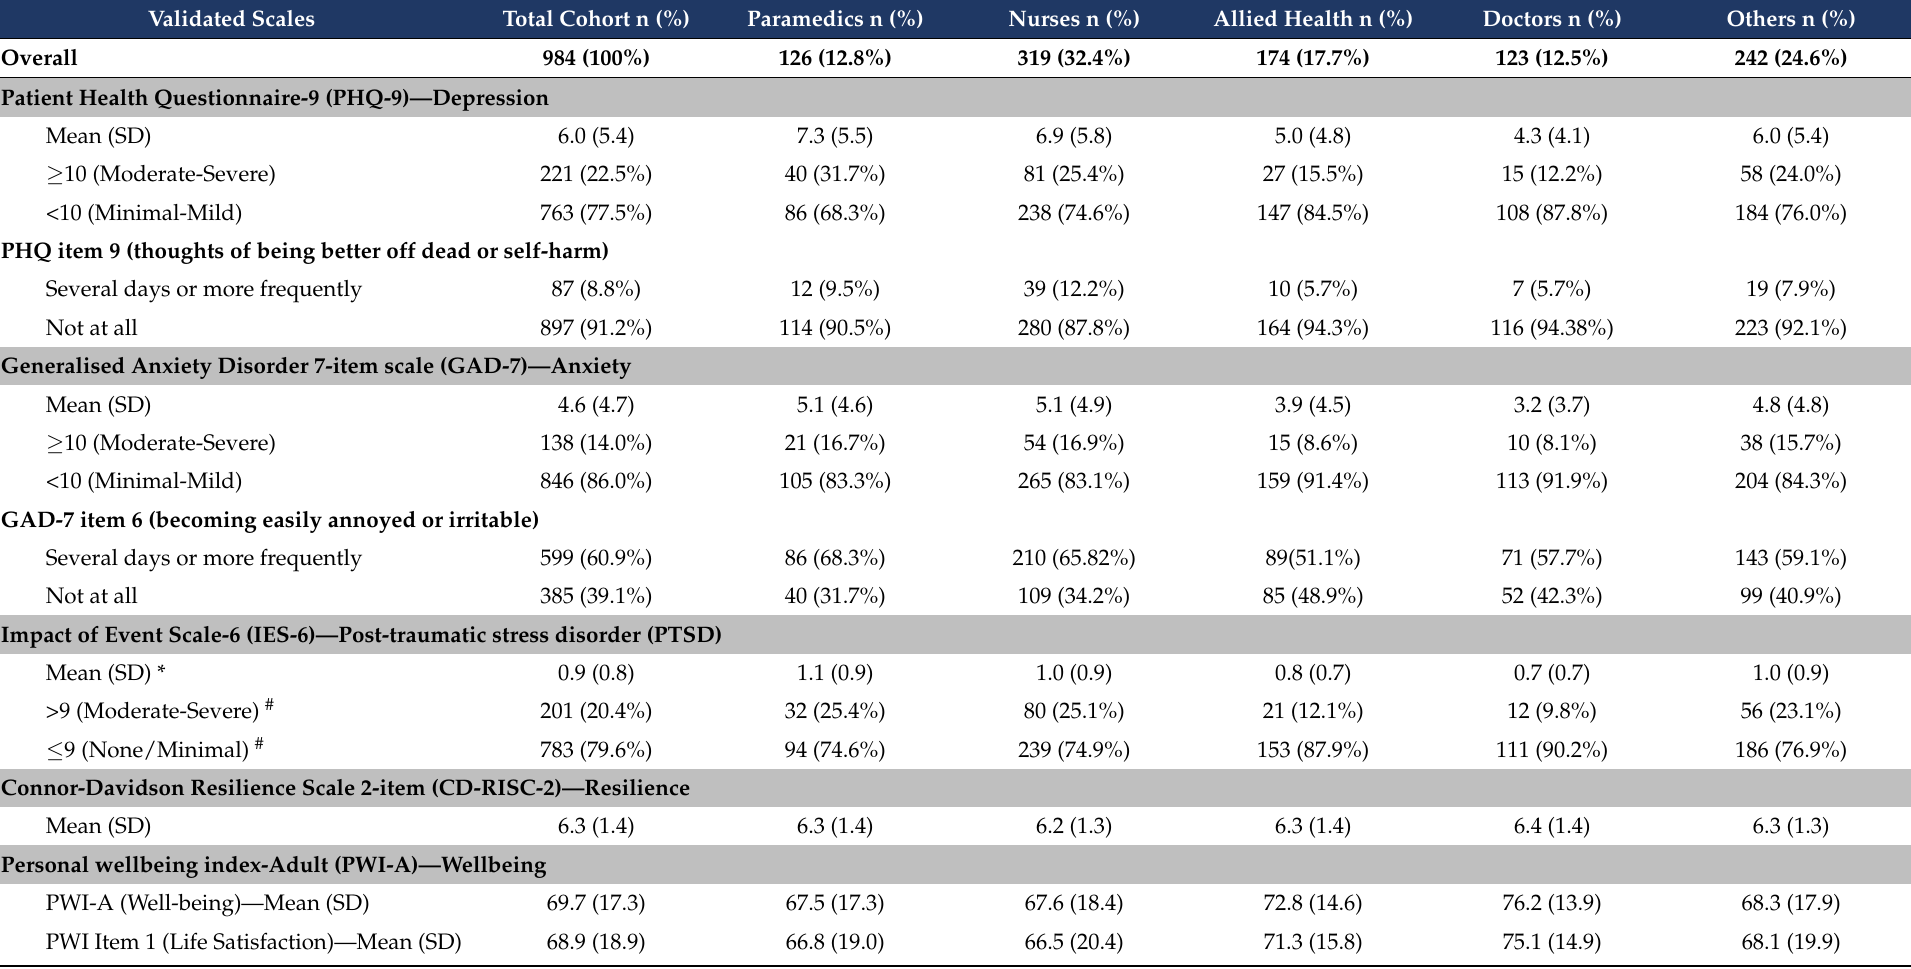
Table 2. Measures of depression, anxiety, post-traumatic stress, resilience, wellbeing, life satisfaction, burnout, and optimism across occupations. Validated